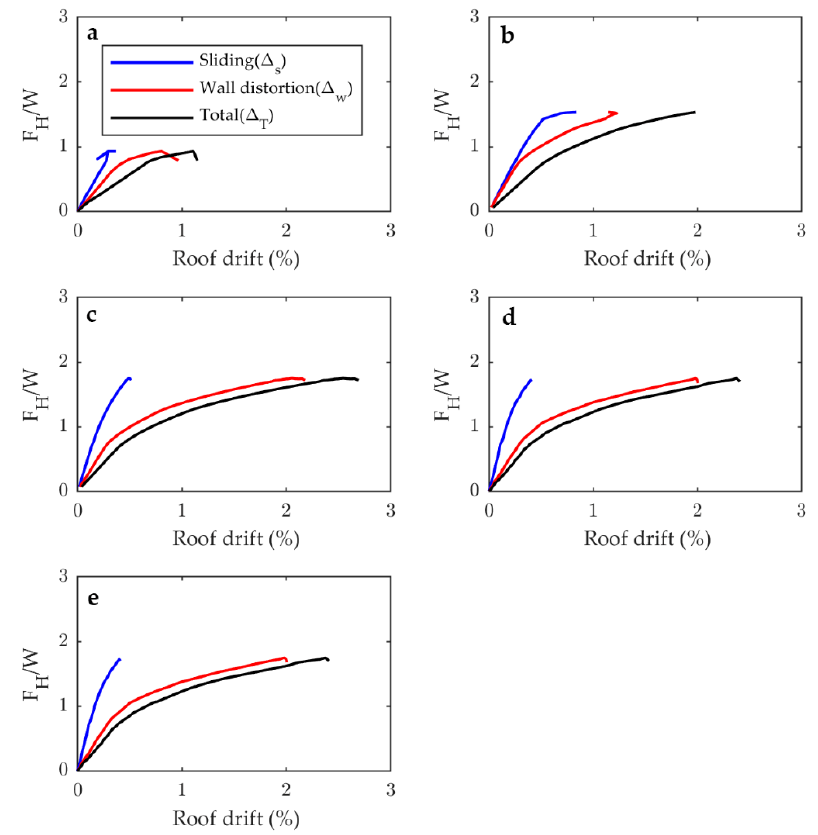
Figure 7. Effects of the alpha index on the contributions of wall sliding and distortion in the story = 0.5, ( b ) α = 1.0, ( c ) α = 2.0, ( d ) α = 3.0, and ( e ) α = deformation: ( a ) 𝛼 = 0.5 , ( b ) 𝛼 = 1.0 , ( c ) 𝛼 = 2.0 , ( d ) 𝛼 = 3.0 , and ( e ) 𝛼 = 4.0 . deformation: ( a ) α